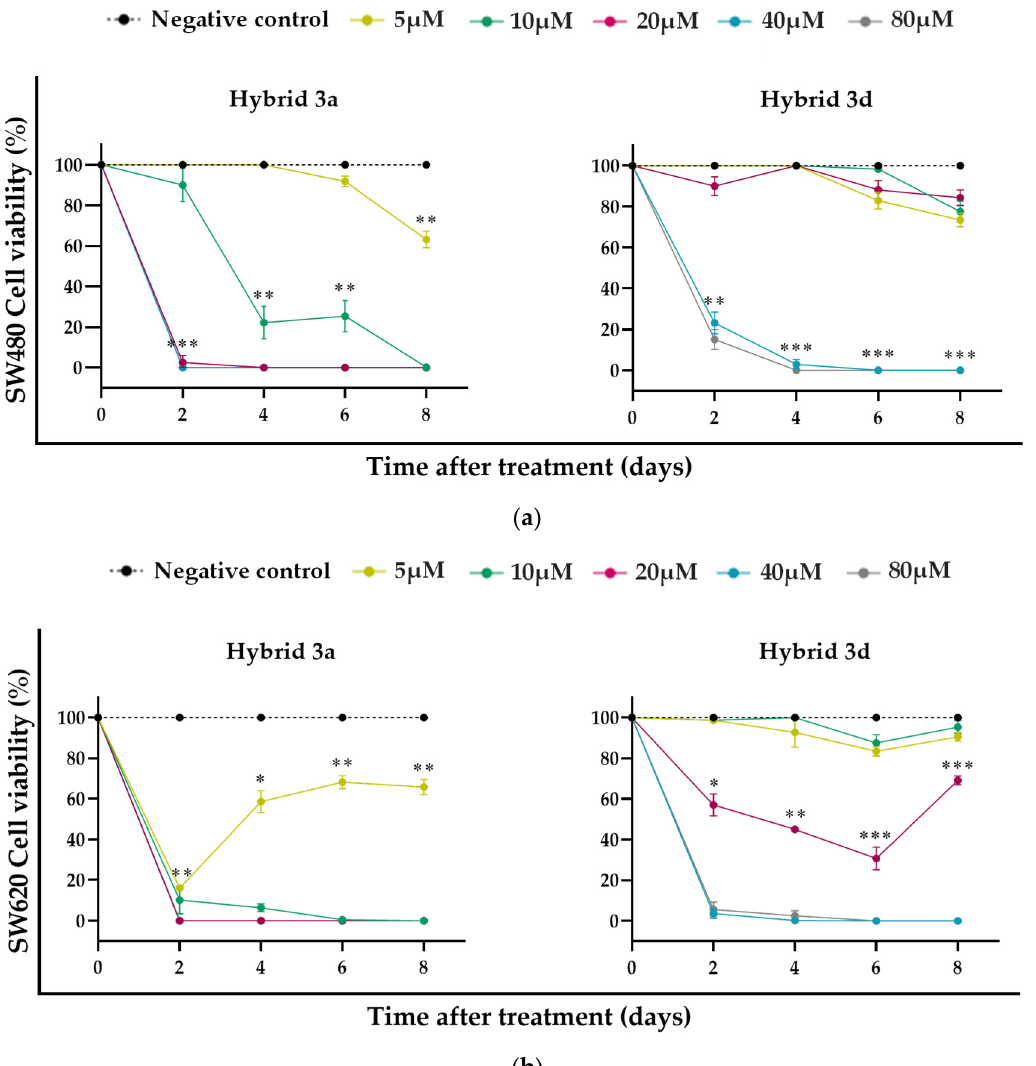
Figure 2. Antiproliferative effect of styrylquinolines 3a and 3d in the ( a ) SW480 and ( b ) SW620 cell lines. Data are presented as the mean ± SE of at least three replicates (* p < 0.05; ** p < 0.01; *** p < 0.001 vs. negative control). The negative control was assumed as 100% cell viability.